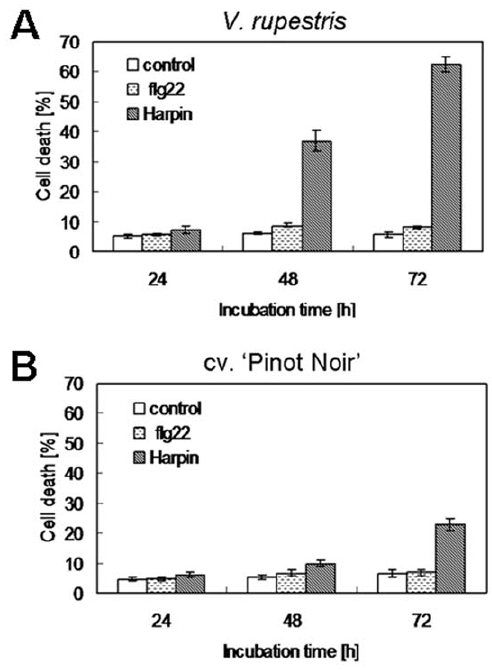
Figure 7. Time course of cell mortality in response to flg22 and Harpin. The relative frequency of dead cells after treatment with flg22 (1 m M, dotted bars) or Harpin (9 m g . ml 2 1 , shaded bars) as compared to the water control (white bars) in V. rupestris ( A ) and V. vinifera cv. ‘Pinot Noir’ ( B ) was followed over time scoring samples of 1500 cells for each data point. Mean values and standard errors from four independent experimental series are shown.